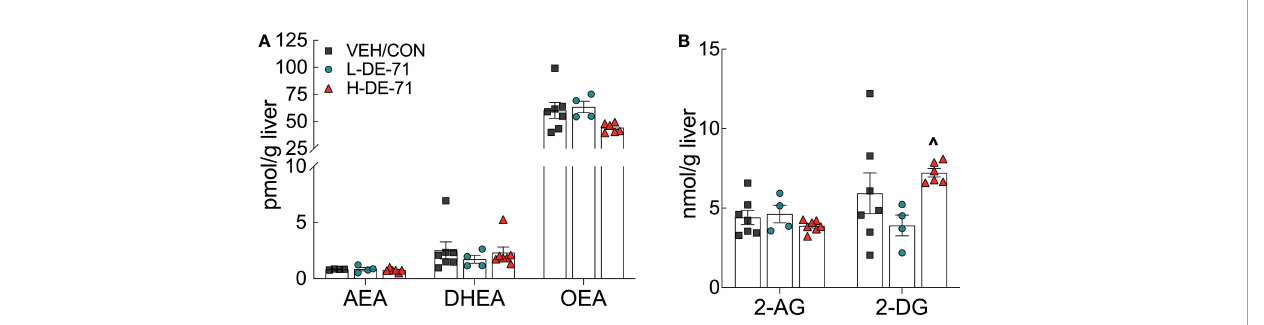
FIGURE 8 Hepatic levels of endocannabinoid (EC) and related fatty acid ethanolamides in DE-71 exposed male mice. Post mortem liver tissue was analyzed using UPLC/MS/MS. (A) AEA, DHEA and OEA. (B) 2-AG and 2-DG. ^indicates signi fi cantly different from L-DE-71 (^p < 0.05). Bars and error bars represent values expressed as mean ± s.e.m. n , 4-7/group. AEA, arachidonoylethanolamide (Anandamide); DHEA, docosahexanoyl ethanolamide; OEA, n-oleoyl ethanolamide; 2-AG, 2-arachidonoyl- sn -glycerol; 2-DG, monoacylglycerol 2-docosahexaenoyl- sn